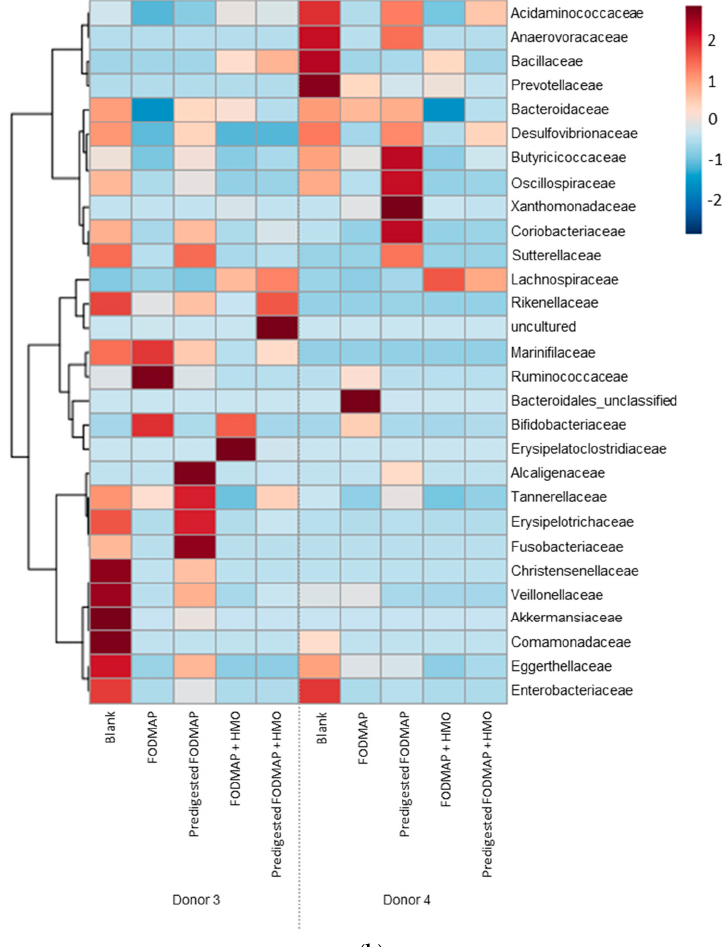
Figure 7. Heatmaps of microbial community composition on day 9/10 according to donor and treatment at the phylum level ( a ) and family level ( b ) in the QuintSHIME ® model. TC samples collected on day 9 and day 10 were considered replicates. The color of the legend represents the Z-score for each feature among the samples. Z-scores are computed on a feature-by-feature (row-by-row) basis, by subtracting the mean and then dividing by the standard deviation. This has been added to the figure caption of the revised manuscript. FODMAP = fermentable oligosaccharides, disaccharides, monosaccharides, and polyols; HMO = human milk oligosaccharide; SHIME, SHIME = simulator of the human intestinal microbial ecosystem; TC = transverse colon.